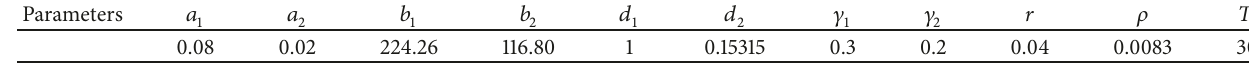
Table 1: Parameters’ values for numerical solution.